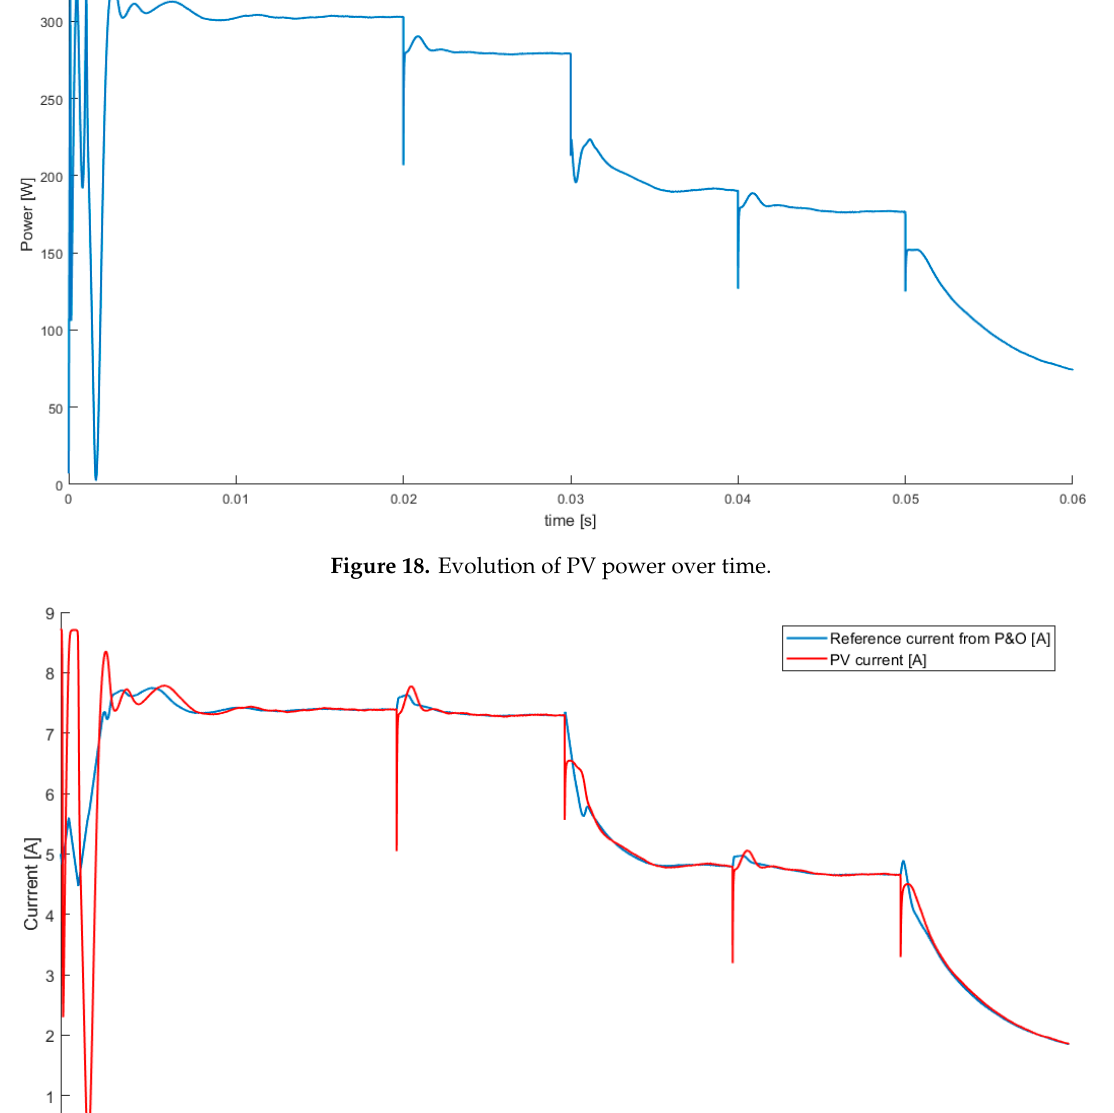
Figure 17. System architecture including the P&O algorithm.